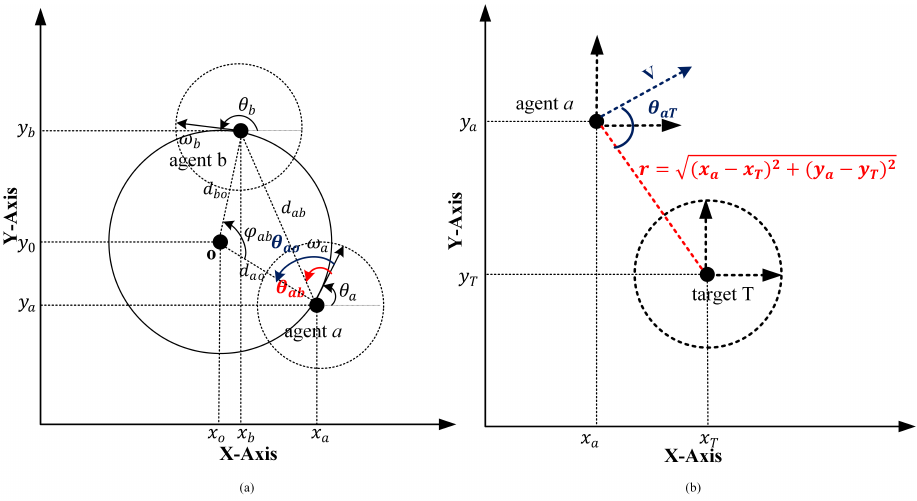
Figure 2. Circular formation measurements setup: ( a ) bearing measurement setup; ( b ) range mea- surement